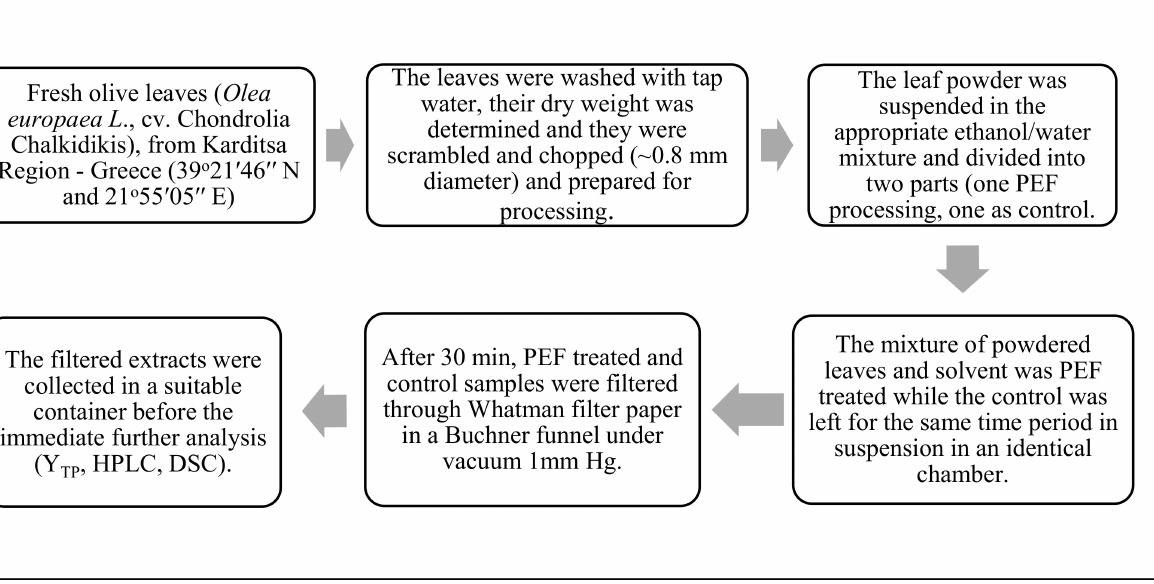
Figure 1. Plant material processing steps. Abbreviations: pulsed electric field (PEF); total phenol content ( Y TP ); high performance liquid chromatography (HPLC); differential scanning calorimetry